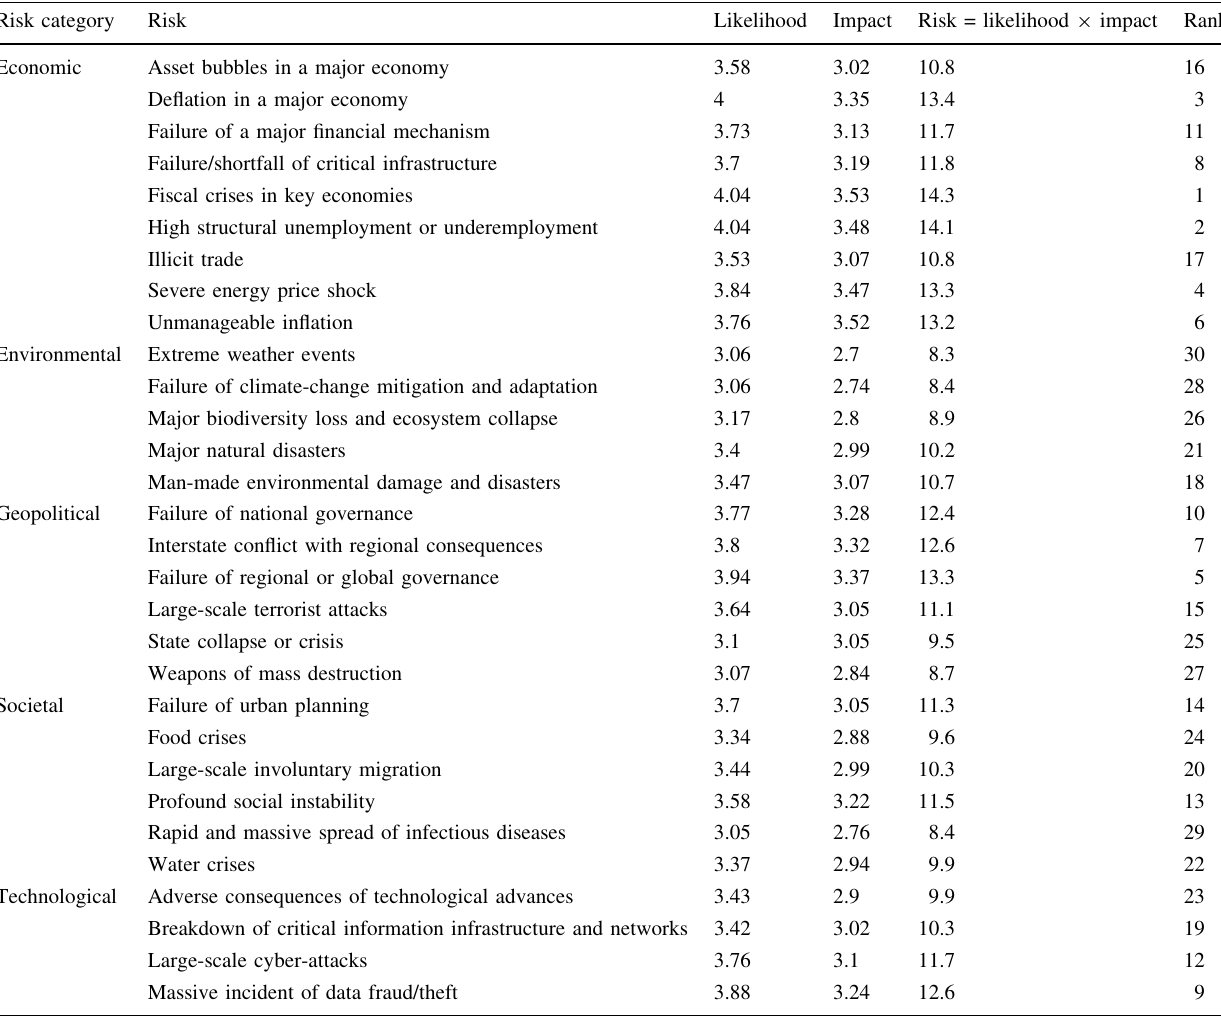
Table 2 Mean likelihood and impact of global risks as perceived by the surveyed small and medium enterprises in Turkey (N = 217) Risk category Risk